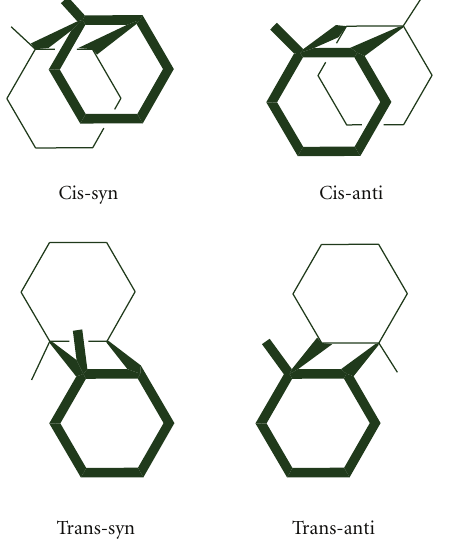
Figure 4: Possible diastereoisomers of pyrimidine T <> T dimer.